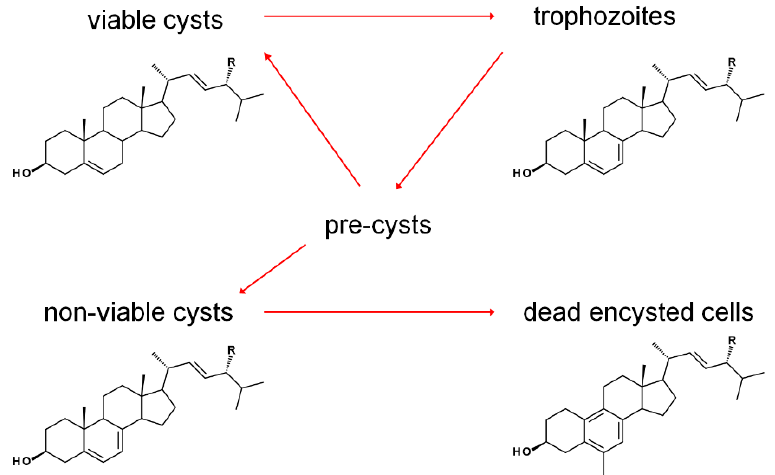
Figure 10. Growth-phase dependence of predominant sterols in A. castellanii . R = Me and Et. Adapted from [36].